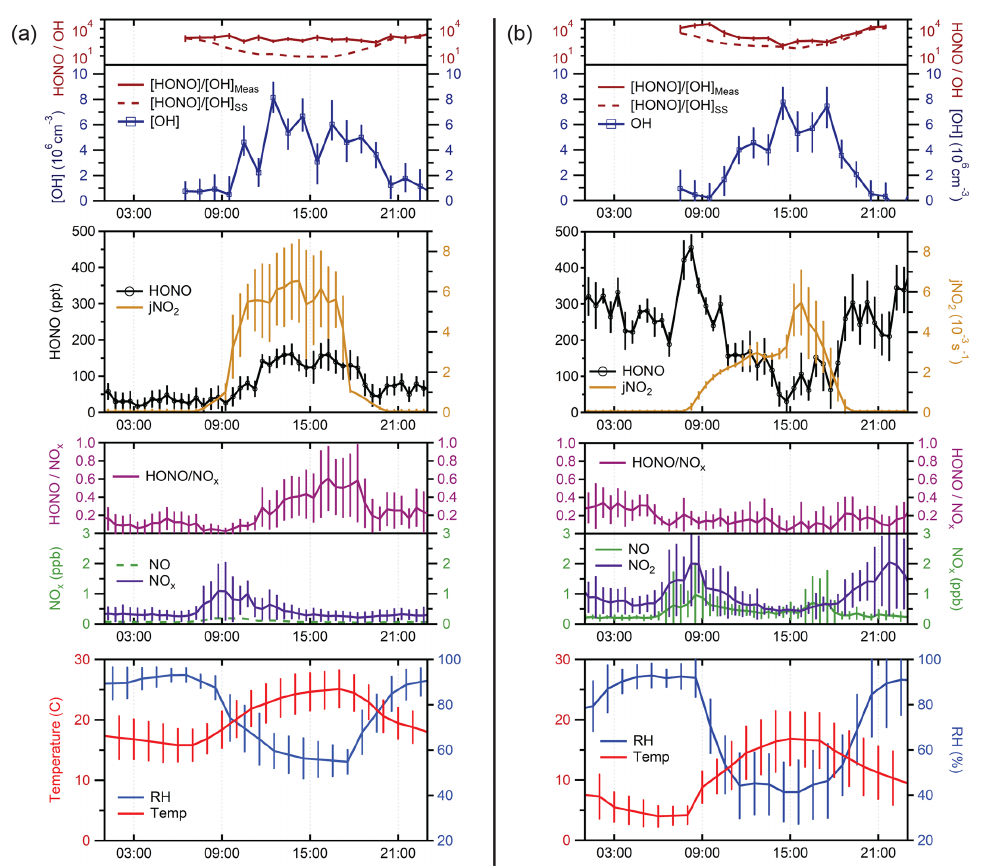
, temperature, RH, NO x , and HONO / NO x from (a) the forested site 2 at 15:00. Error bars represent the standard deviation of the 2